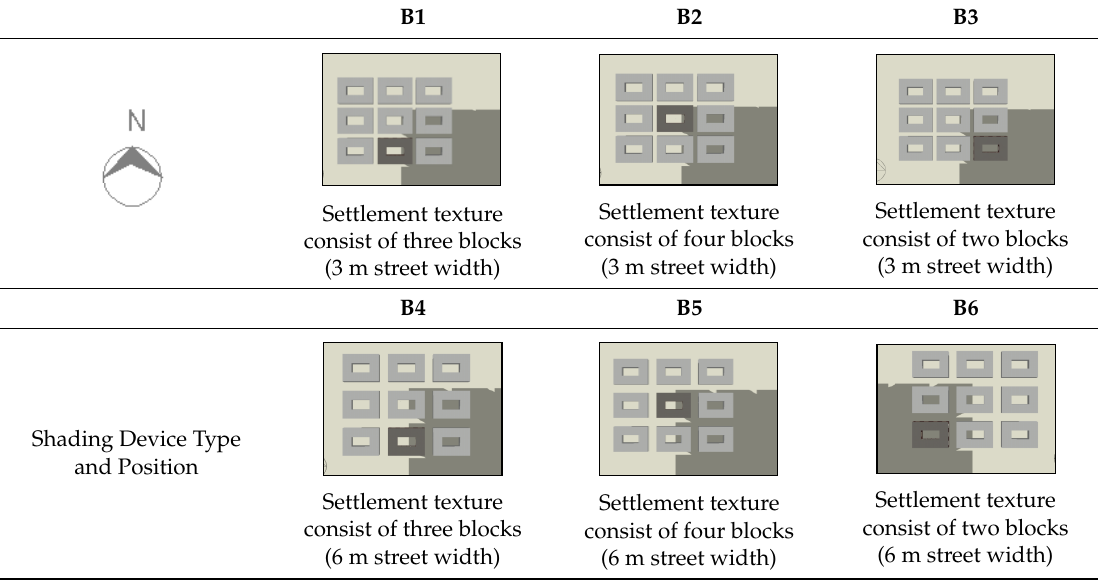
Figure 5. Reference courtyard form and dimensions (m). Table 7. Different settlement layouts with streets with widths of 3 and 6 m.